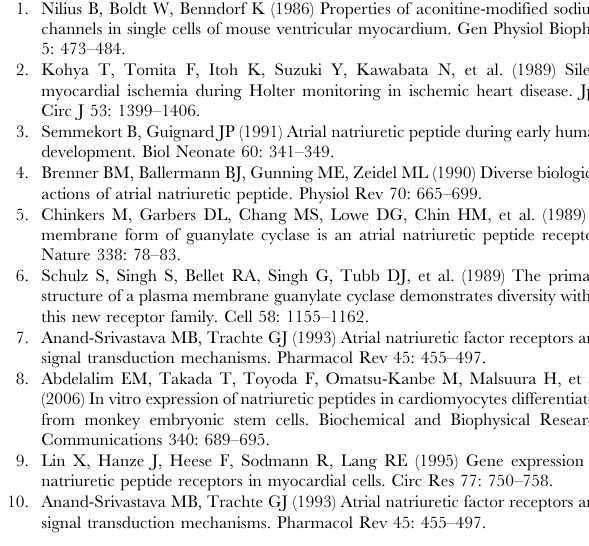
Figure S2 Effects of 8-Bromo-cGMP on L-type Ca 2 + current in EDS cardiomyocytes. Time course of ICaL demonstrates that 8- Bromo-cGMP (200 m M) depresses ICaL (A), and the effect of 8- Bromo-cGMP on ICaL is abolished by pre-treatment of the cells with EHNA, a specific inhibitor of PDE2 (B). C, percentage of cells responding to 8-Bromo-cGMP. D, density of peak